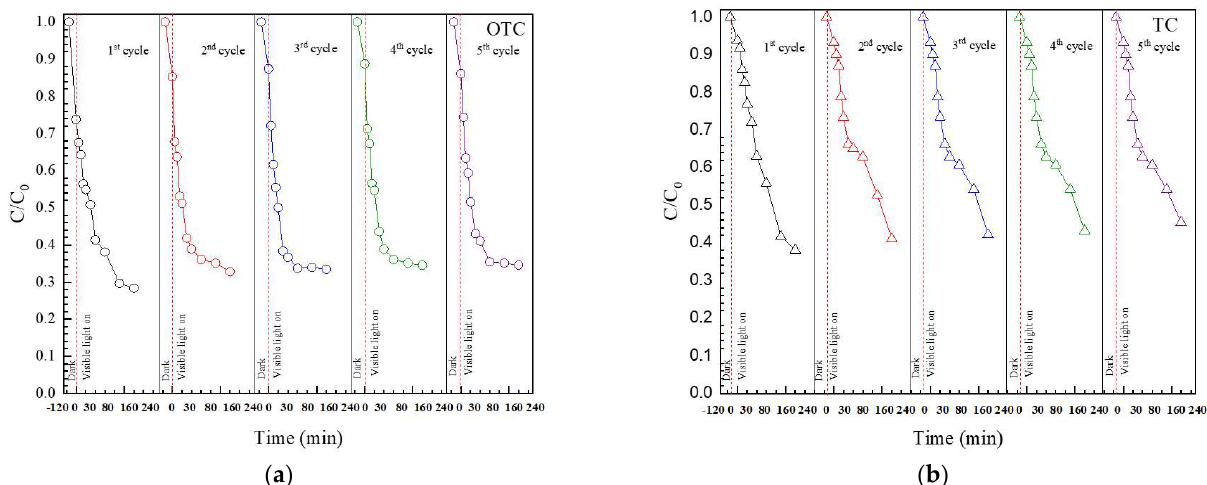
Figure 11. Reusability of the BiVO 4 catalyst toward degradation of OTC ( a ) and TC ( b ).